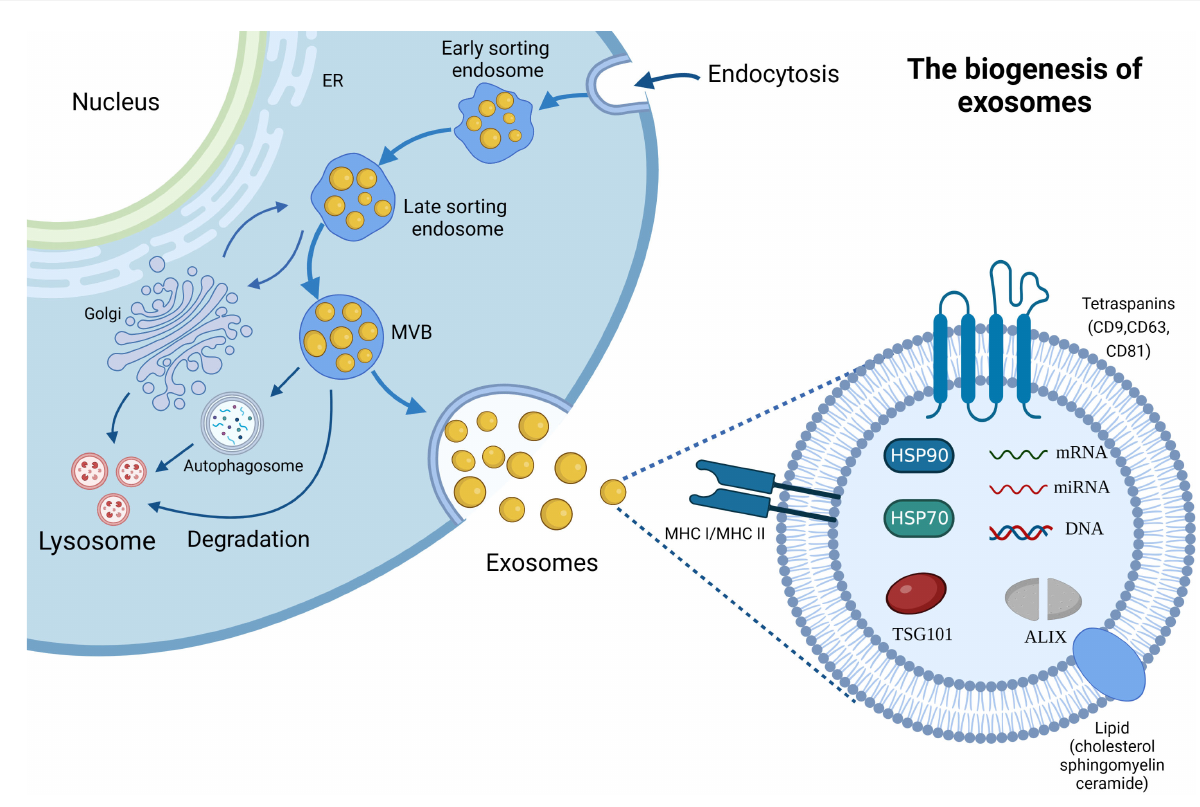
FIGURE 2 The biogenesis and composition of Exos. ER; Endoplasmic reticulum, MVB; Multivesicular